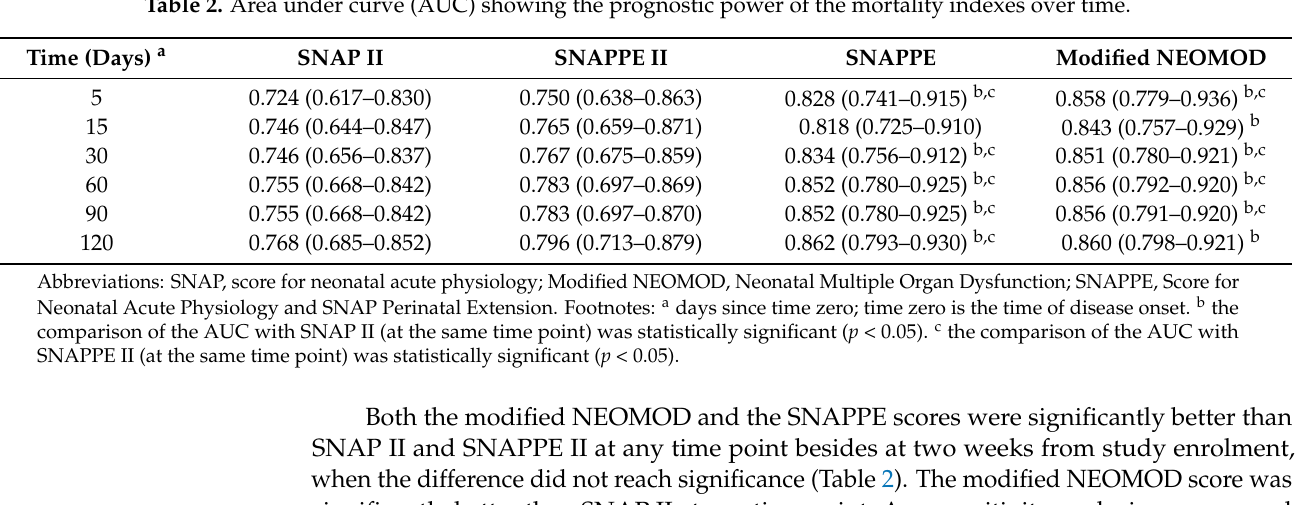
Table 3. Area under the Curve (AUC) showing the prognostic power of mortality indexes for preterm and term infants over time.